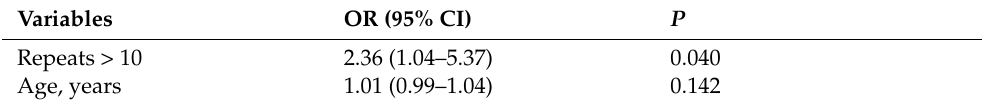
Table 3. Multivariate regression analysis for the probability to receive invasive mechanical ventilation (MV) or non-invasive ventilation (NIV). Variables OR (95% CI)